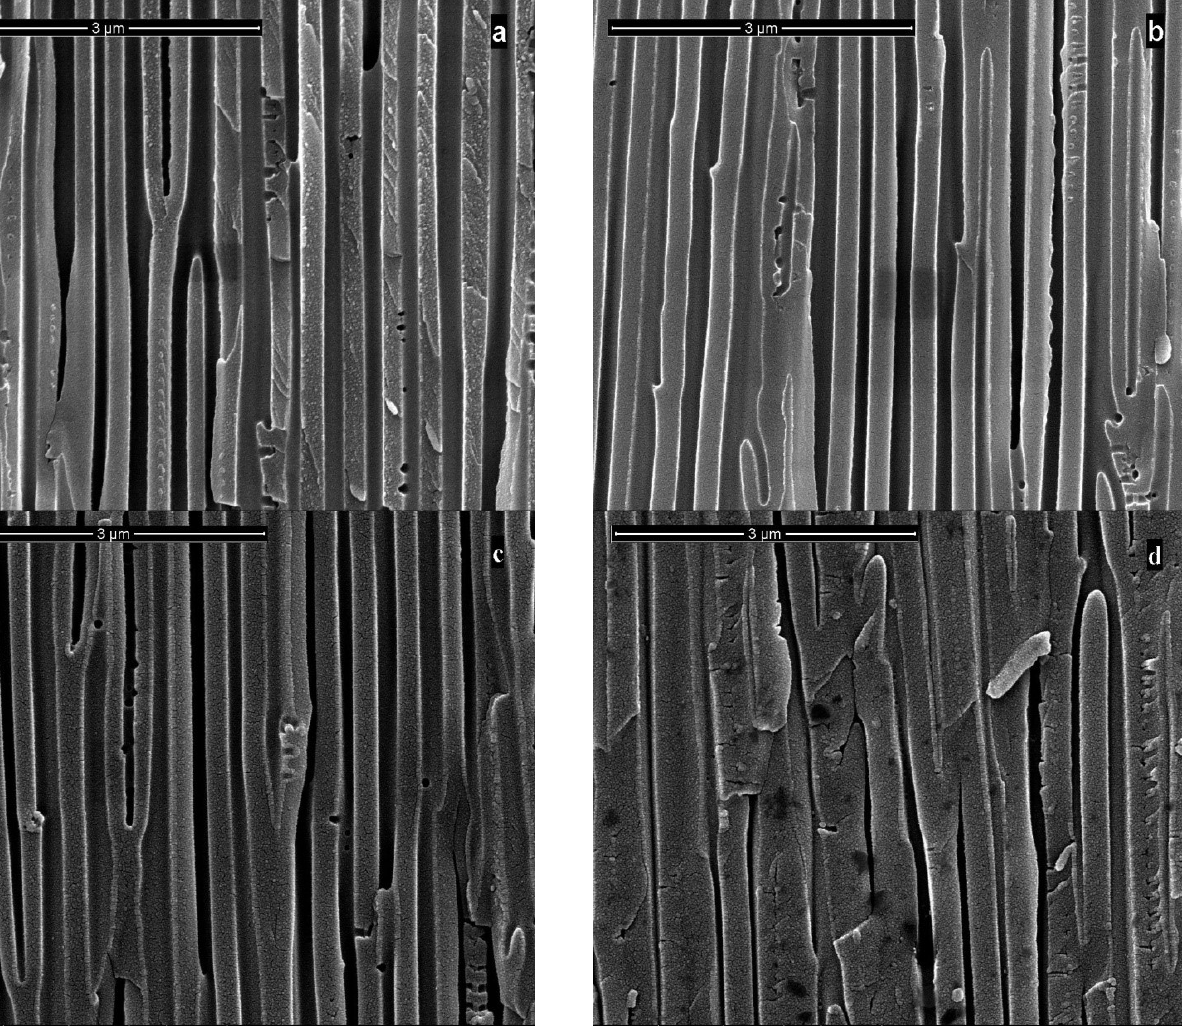
Figure 8. Section views of PAA formed at 160 V and 0 °C after 160 C cm − 2 in ( a ) 0.4 M H 3 PO 4 ; ( b ) 0.4 M H 3 PO 4 and 0.04 M Al(OH) 3 ; ( c ) 0.4 M H 3 PO 4 and 0.095 M Al(OH) 3 ; ( d ) 0.4 M H 3 PO 4 and 0.13 M Al(OH) 3 . Table 2. PAA layer thickness dependent on the electrolyte composition and passed electrical charge for aluminum anodizing at 160 V and 0 °C.